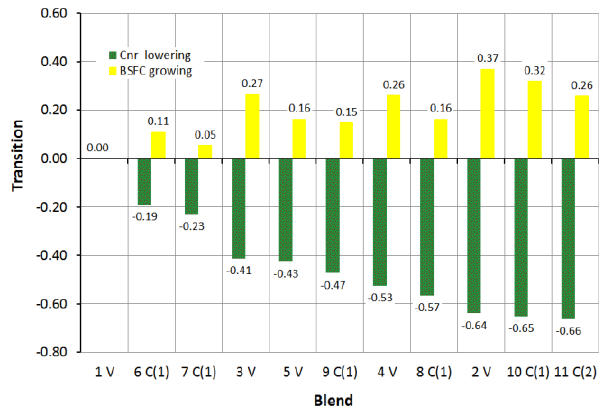
Fig. 6. Carbon from non-renewable sources content lowering and BSFC min grooving Replacing non-renewable carbon with “bio carbon” leads to an increase in fuel consumption (in this case BSFC ). This increase in fuel consumption does not min